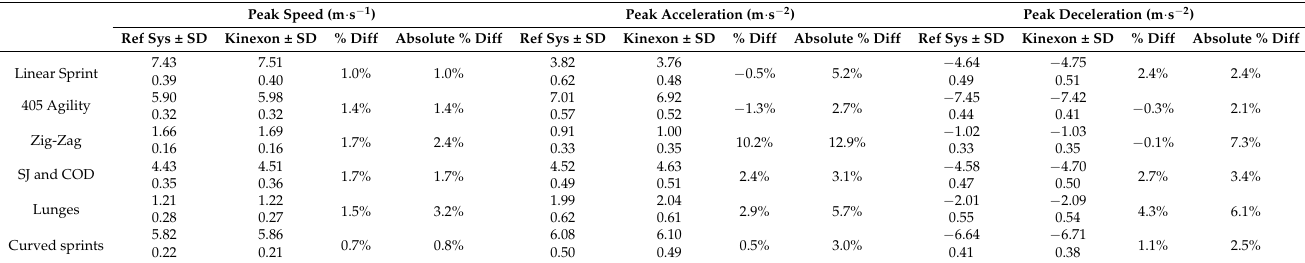
Table 3. Table with peak speed, peak acceleration and peak deceleration of the reference and Kinexon system for different parts of the SSC. Percentage values indicate the differences between both systems.